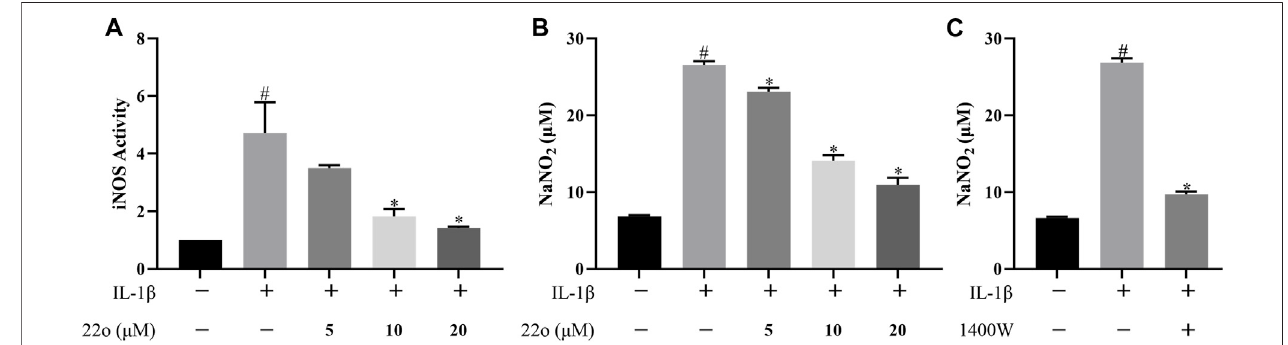
FIGURE 2 | Compound 22o inhibits iNOS activity and NO production. Rat chondrocytes were treated with different concentrations of compound 22o in the presence or absence of IL-1 β (10 ng/ml) for 24 h. (A) The activity of iNOS was evaluated by Nitric Oxide Synthase Assay Kit ( n = 3). (B , C) Griess reagent was used to measure the NO levels in the culture supernatants ( n = 3). # p < 0.05 vs. control group; * p < 0.05 vs. IL-1 β group.